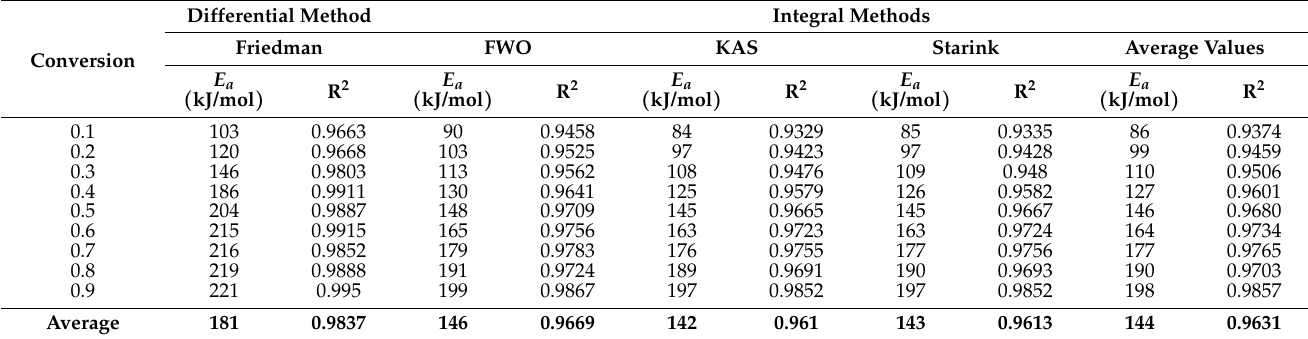
Table 5. Activation energy of the binary mixtures of PP and PS obtained by different model-free models.